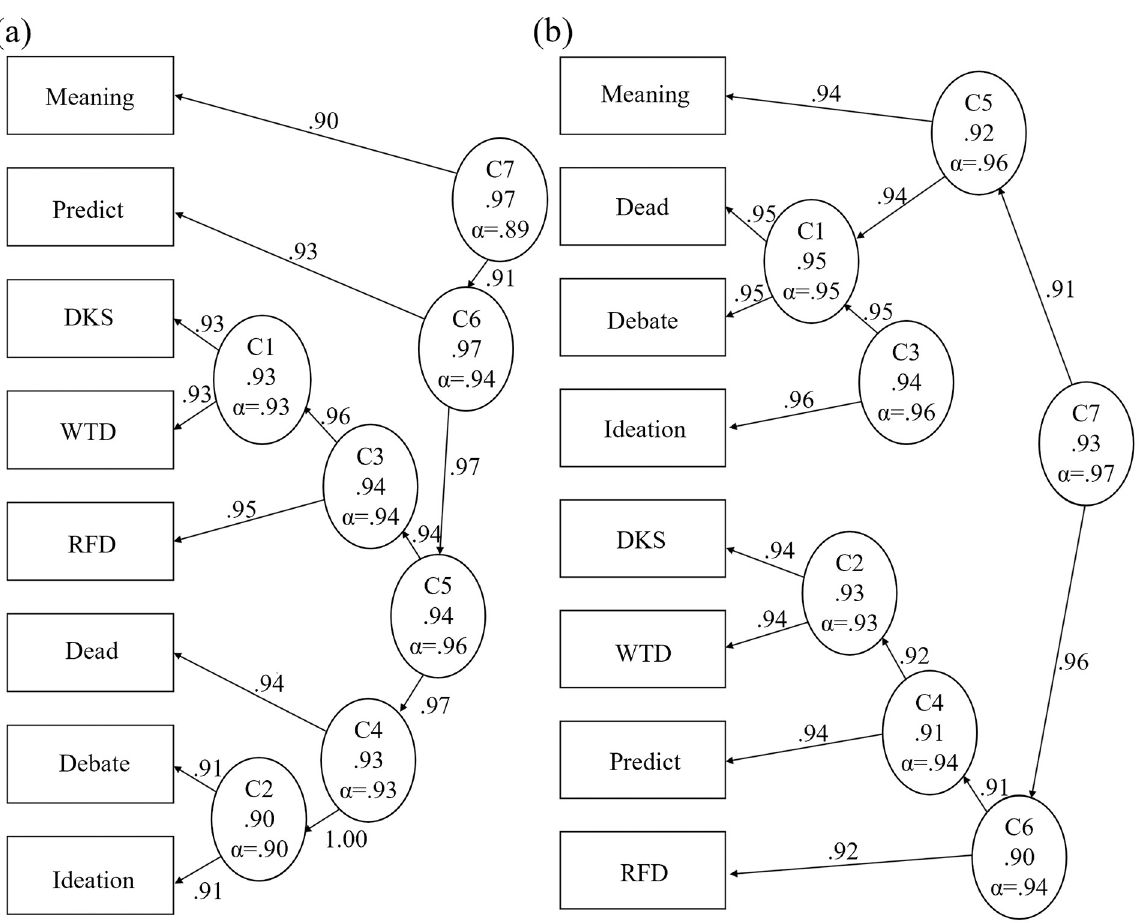
theta levels (Debate, Ideation, Dead, Meaning), and at high theta levels (RFD, WTD, DKS,